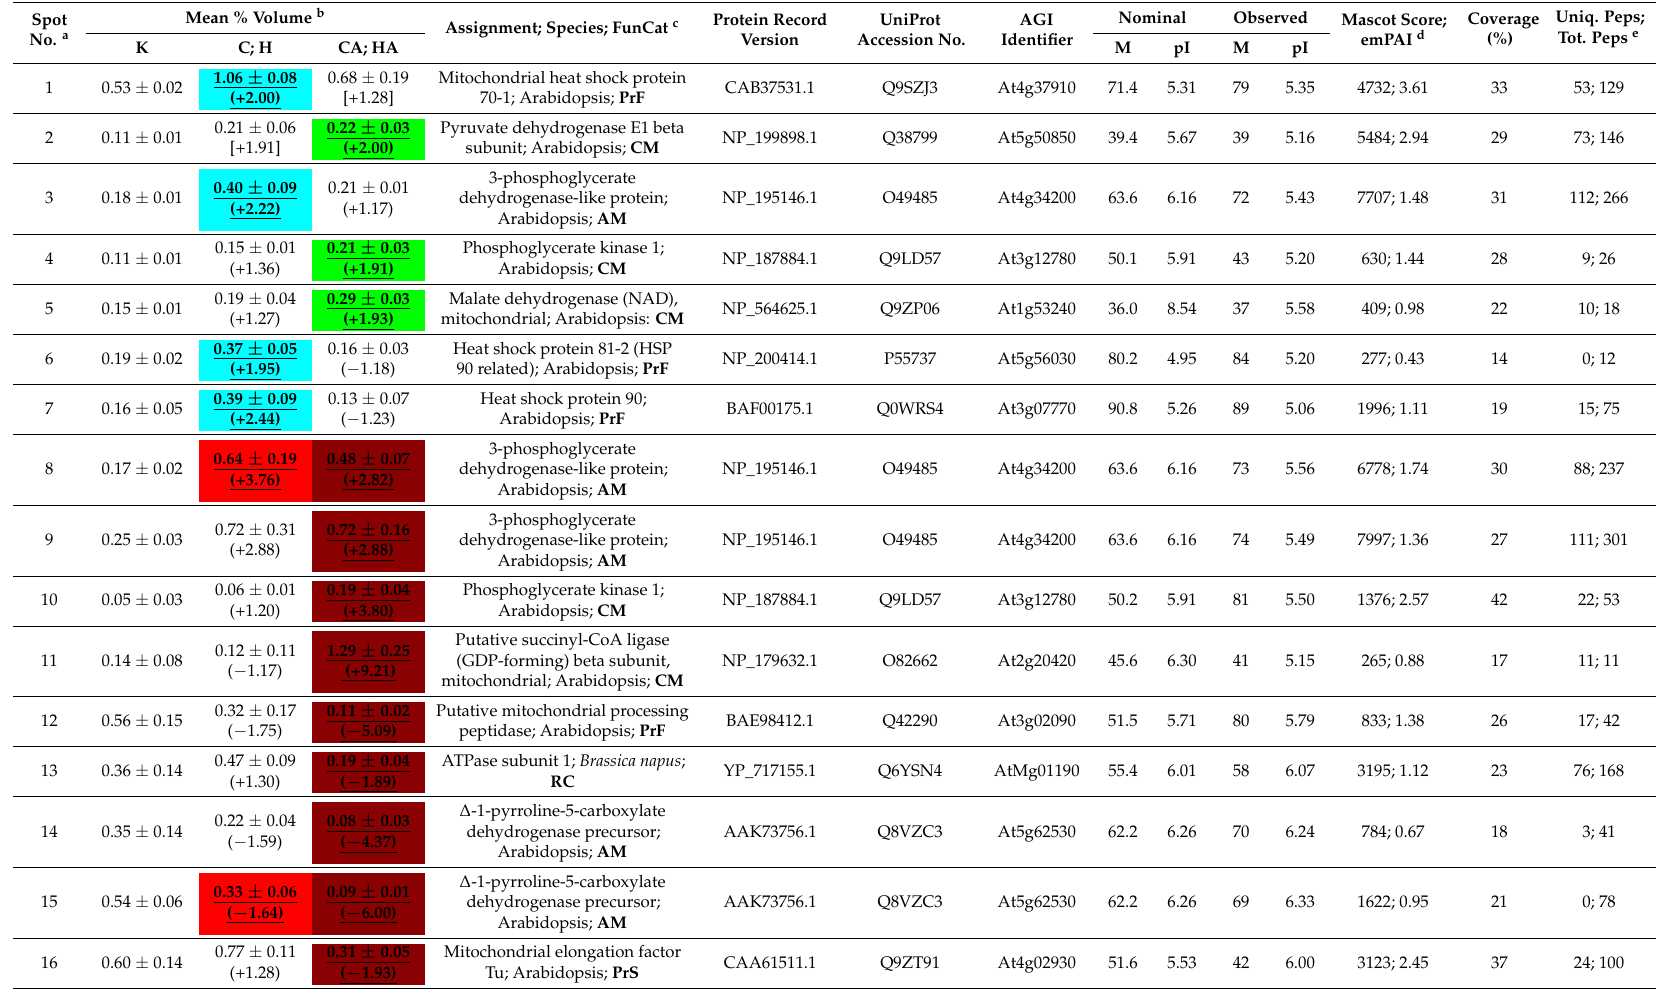
Table 1. List of cauliflower mitochondrial proteins the level of which varied during stress